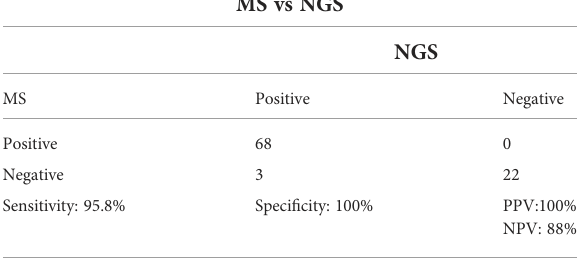
TABLE 1 Comparison of NGS and MS methods in detecting BRAF V600E mutation from FNA